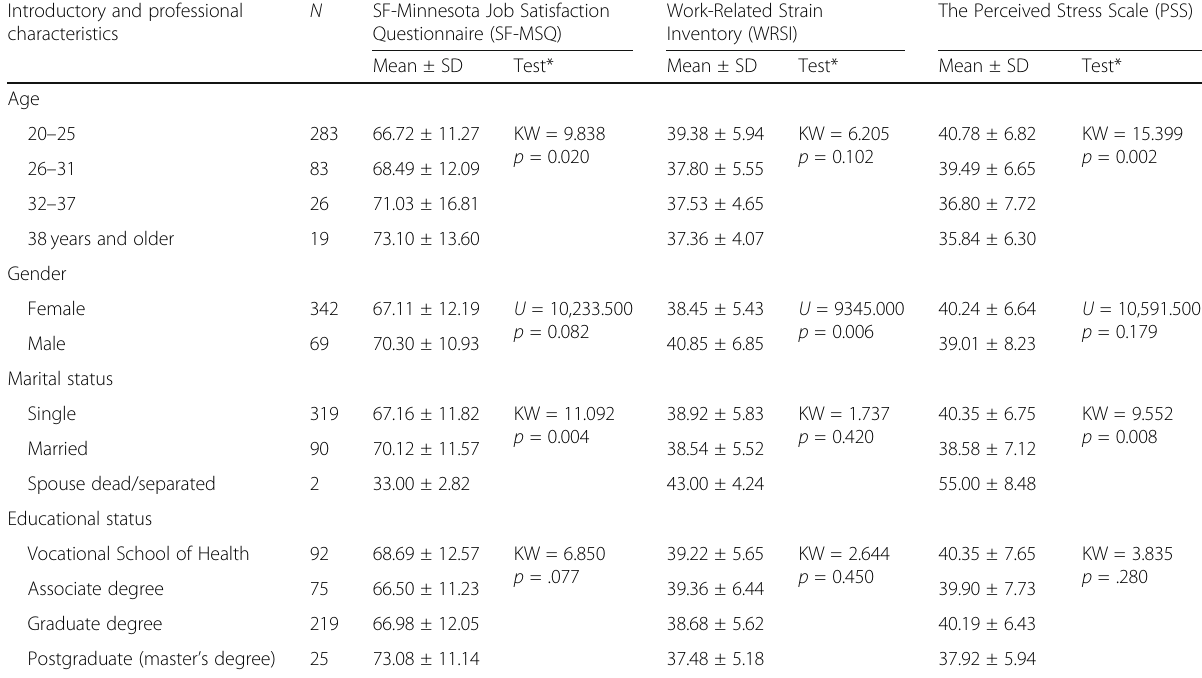
Table 5 Mean scores of SF-MSQ, WRSI, and PSS by the descriptive characteristics of nurses ( N = 411) Introductory and professional characteristics